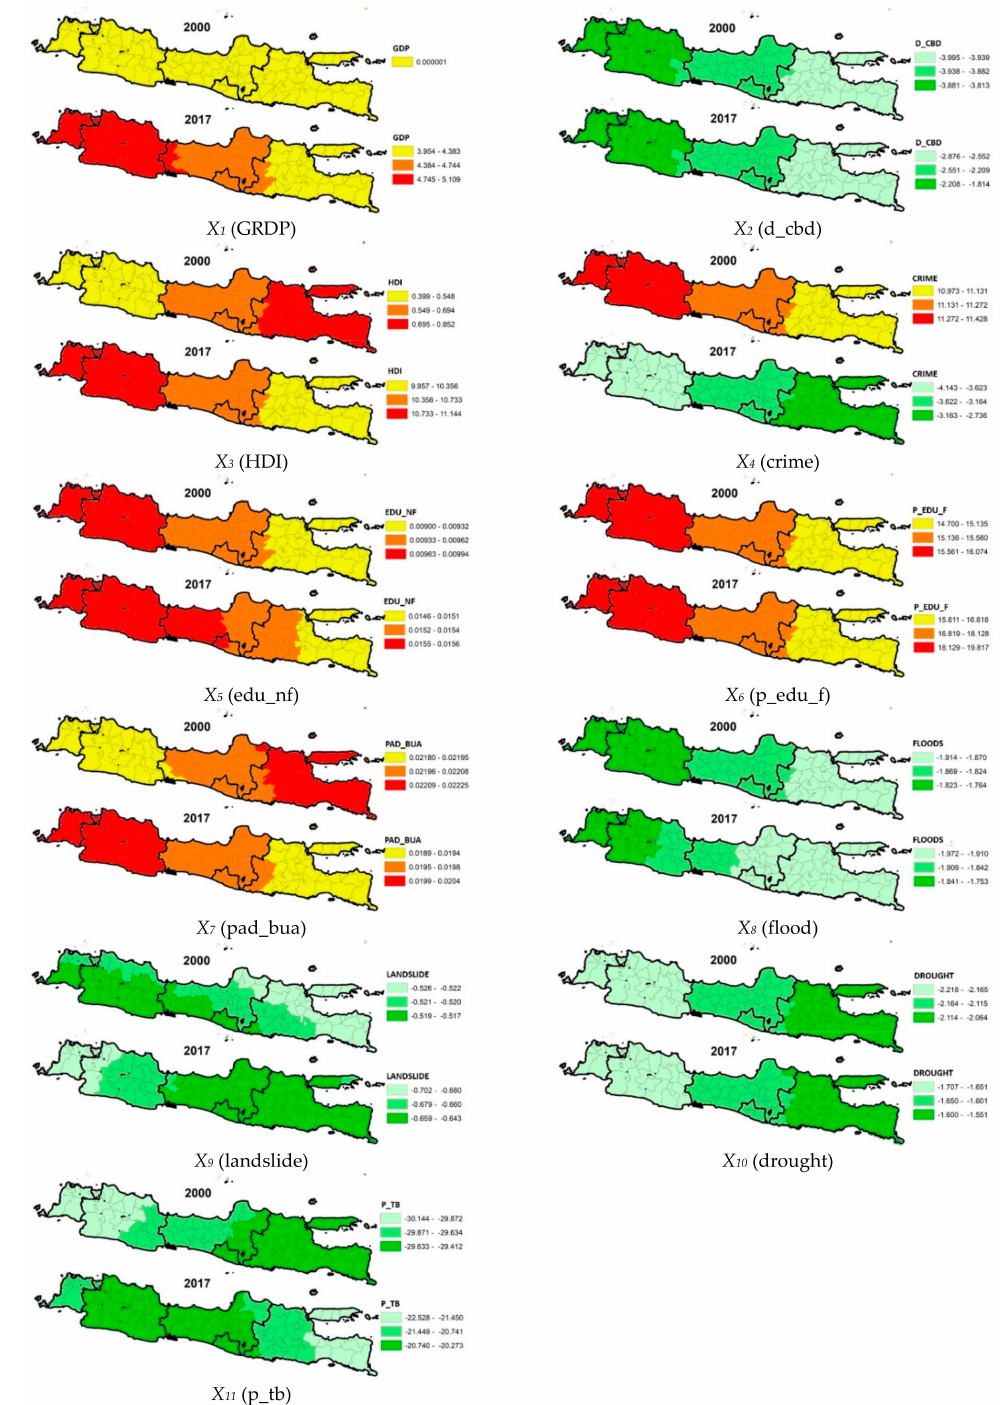
Figure 3. Parameter estimates of independent variables by GWR model. fGRDP (Gross regional domestic product); d_cbd (Distance to the central business district; HDI (Human development index); crime (Crime rate in the region); edu_nf (non-formal educational facilities; p_edu_nf (Ratio of formal educational facilities to the total population; pad_bua (Area converted from paddy to built-up land in the last 3 years; flood (Number of floods); landslides (Number of landslides); drought (Number of drought); p_tb (Percentage of people suffering from